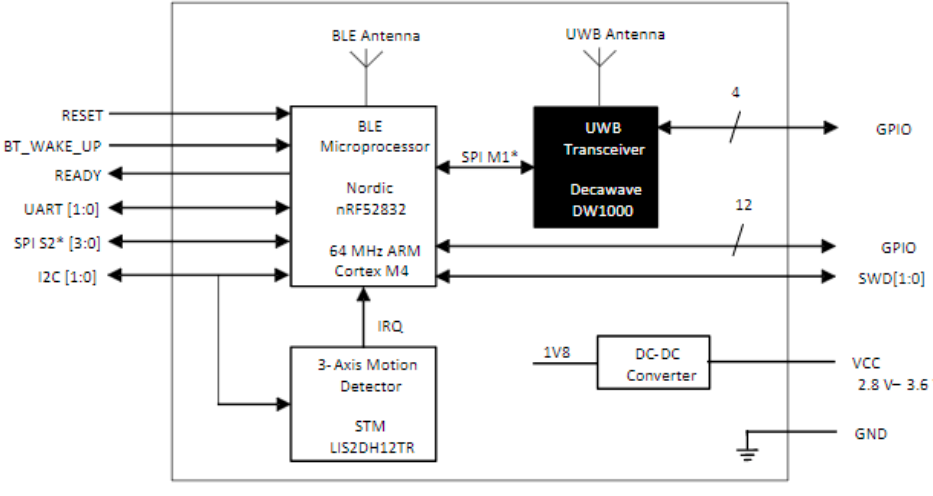
Figure 1. Block diagram of DWM1001 module [35].